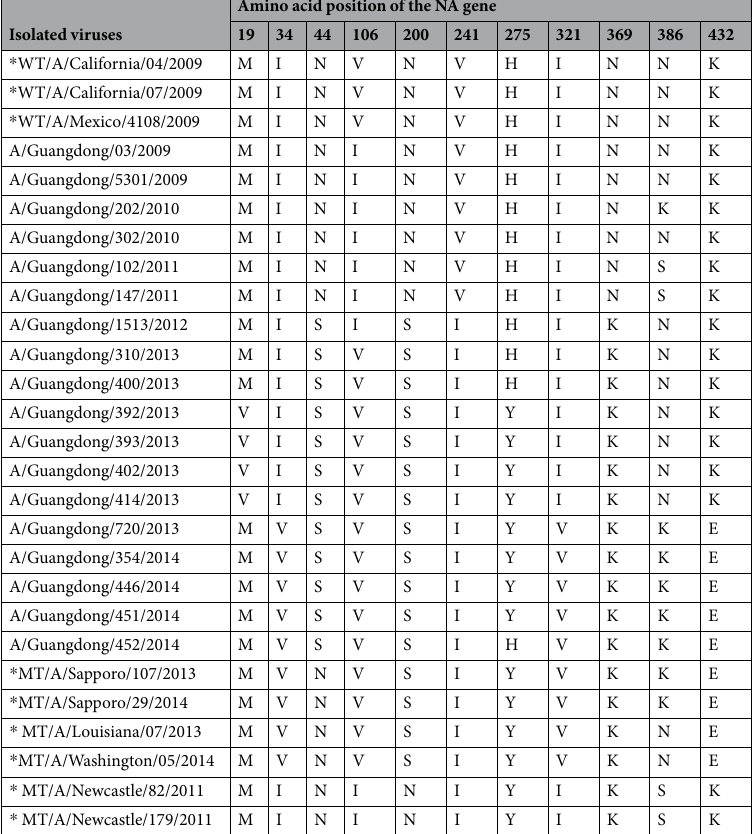
Table 5. Characteristic amino acids of influenza A(H1N1)pdm2009 viruses isolated in Guangdong, China in 2009–2014(n = 18). * Represents reference virus